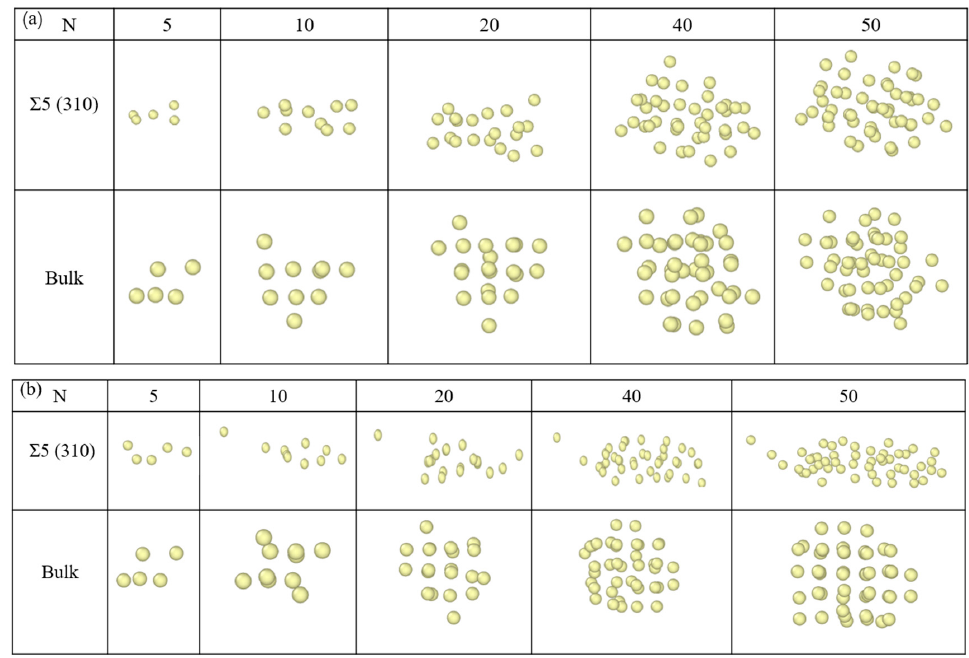
Figure 4. Comparison of the configurations bubbles at the Σ 5(310) GB and bulk UO 2 at ( a ) 1000 K and ( b ) 2000 K.